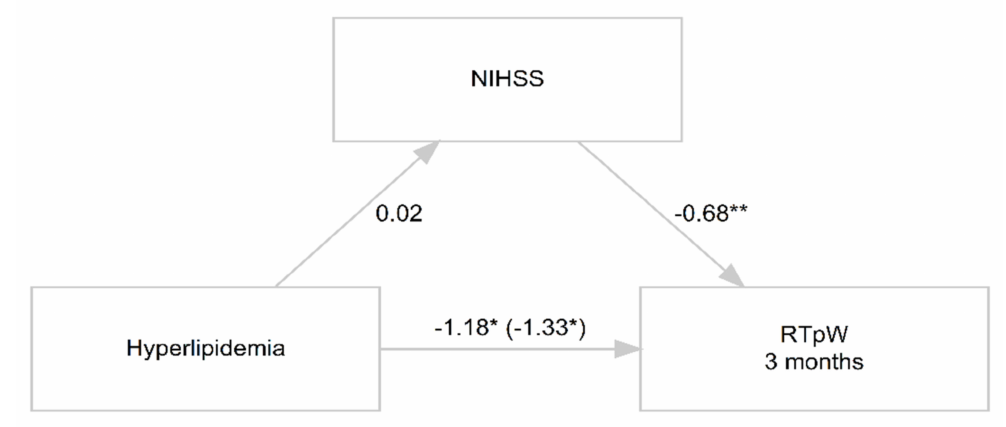
Figure 3. Diagram of three-variable causal mediation analysis results. p < 0.001; * p < 0.05, ** p <